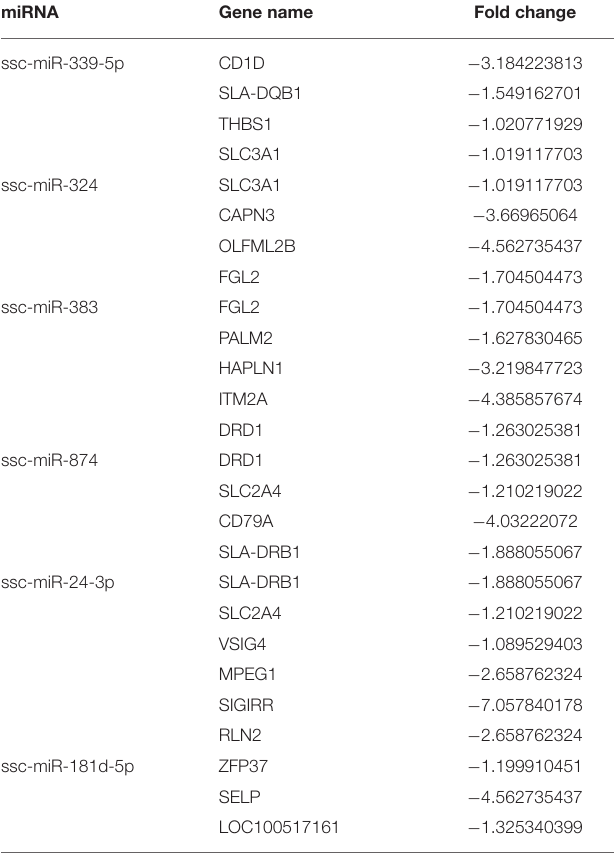
TABLE 5 | Differentially expressed miRNAs and corresponding differentially expressed genes.